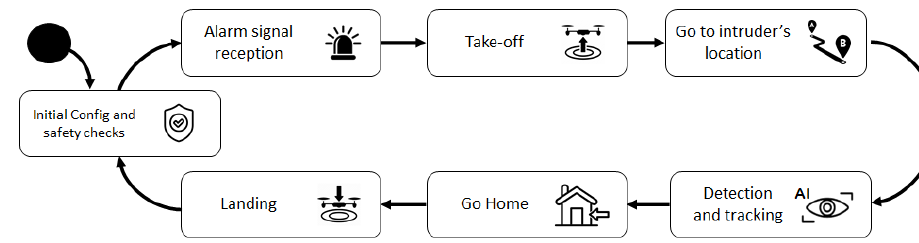
Figure 19. High-level mission state machine.